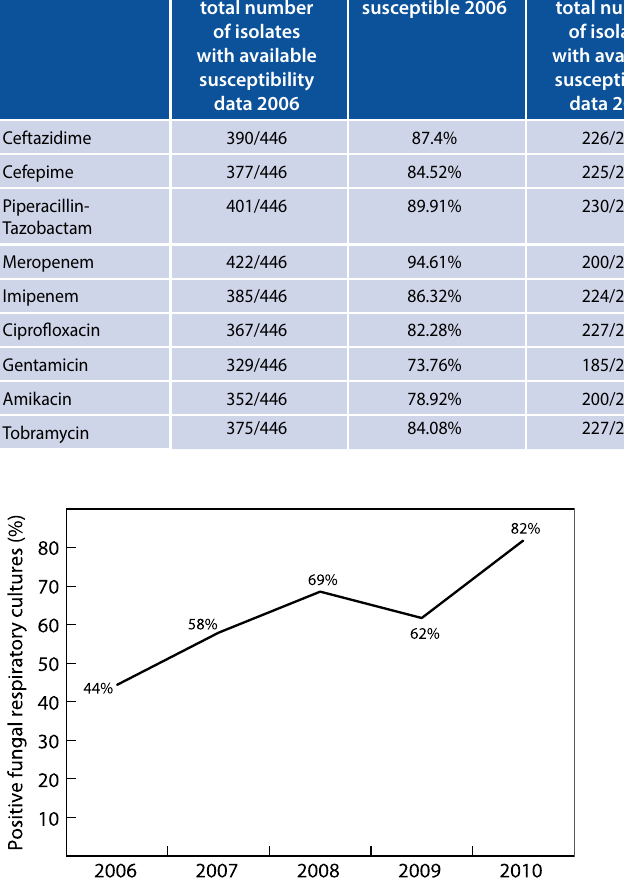
Table 3: Changes to antimicrobial susceptibility among P. aeruginosa isolates Antibiotic